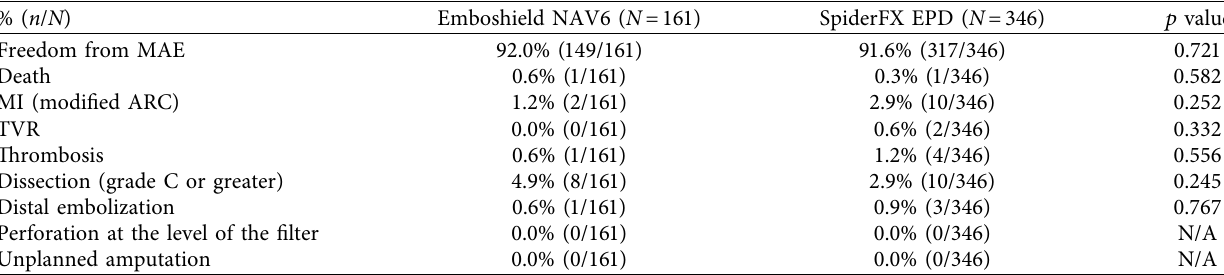
Table 4: Major adverse